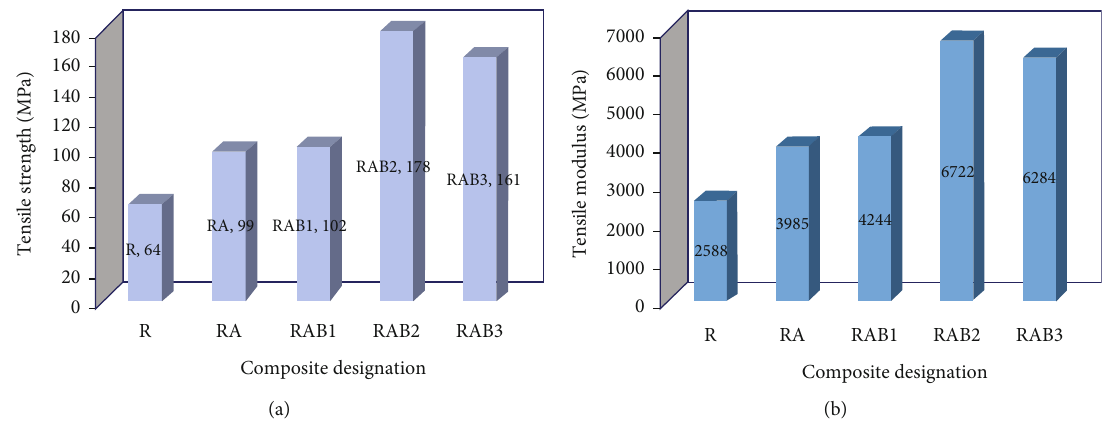
Figure 5: Tensile properties of